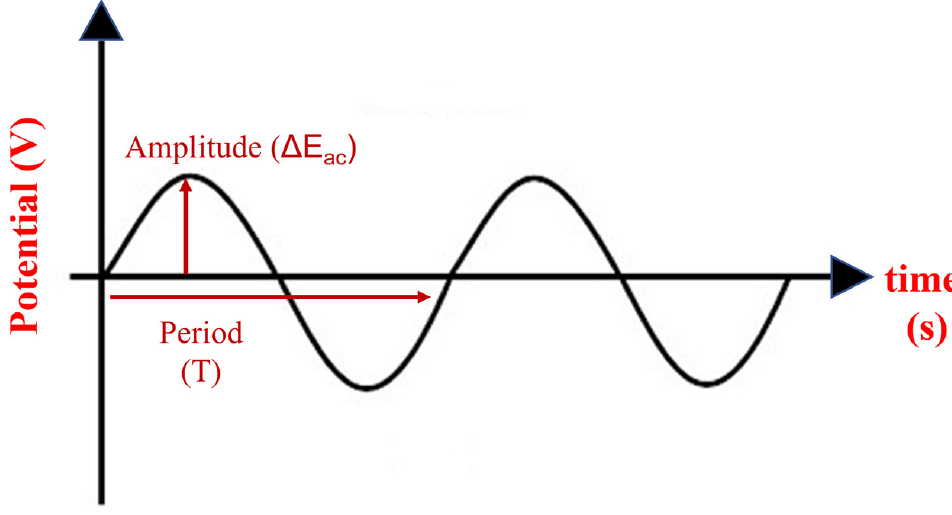
Figure 4. Schematic representation of the SV excitation signal.